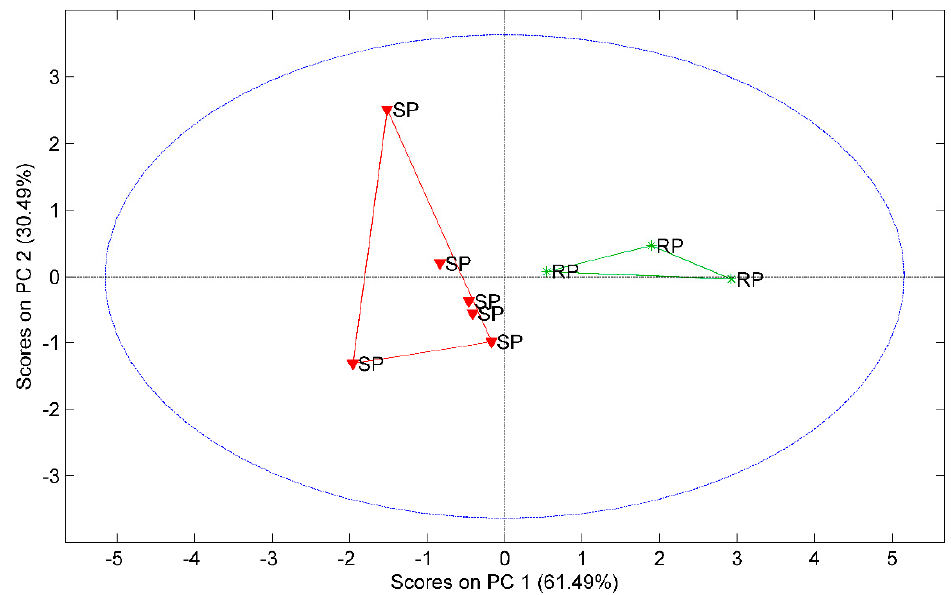
Figure 6. Principal Component Analysis (PCA) with Mössbauer data from the Sambaqui da Panaquatira (SP) and Rabo de Porco (RP) samples.